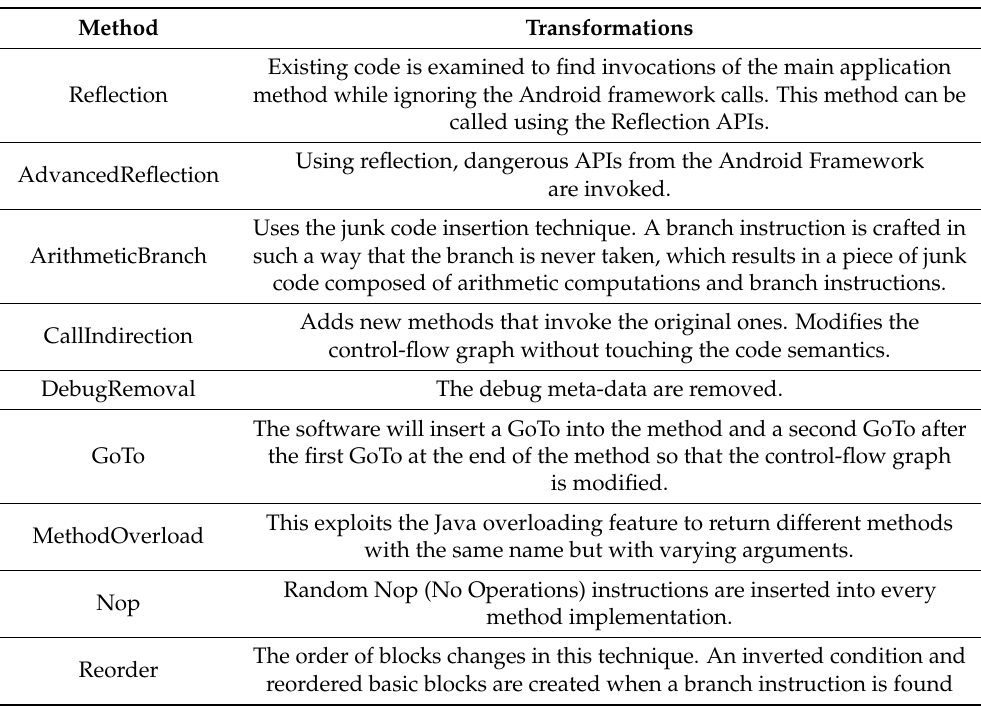
Table 4. Non-Trivial Obfuscation Techniques–Code.